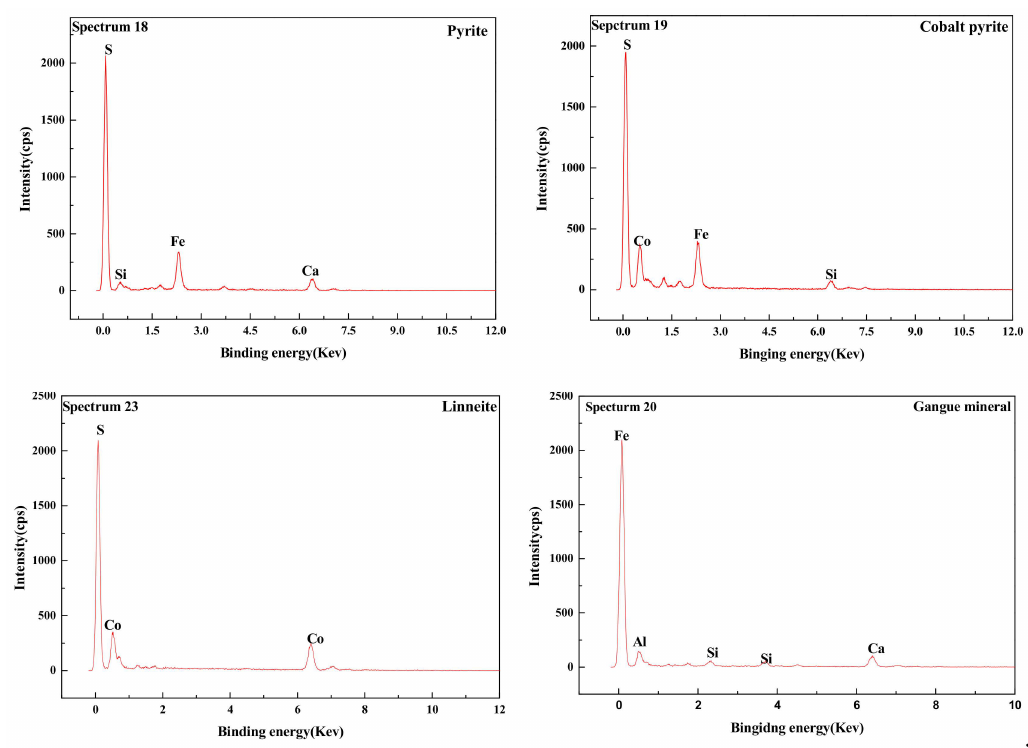
Figure 15. Energy disperse spectroscopy (EDS) spectrum images analysis of cobalt–sulfur